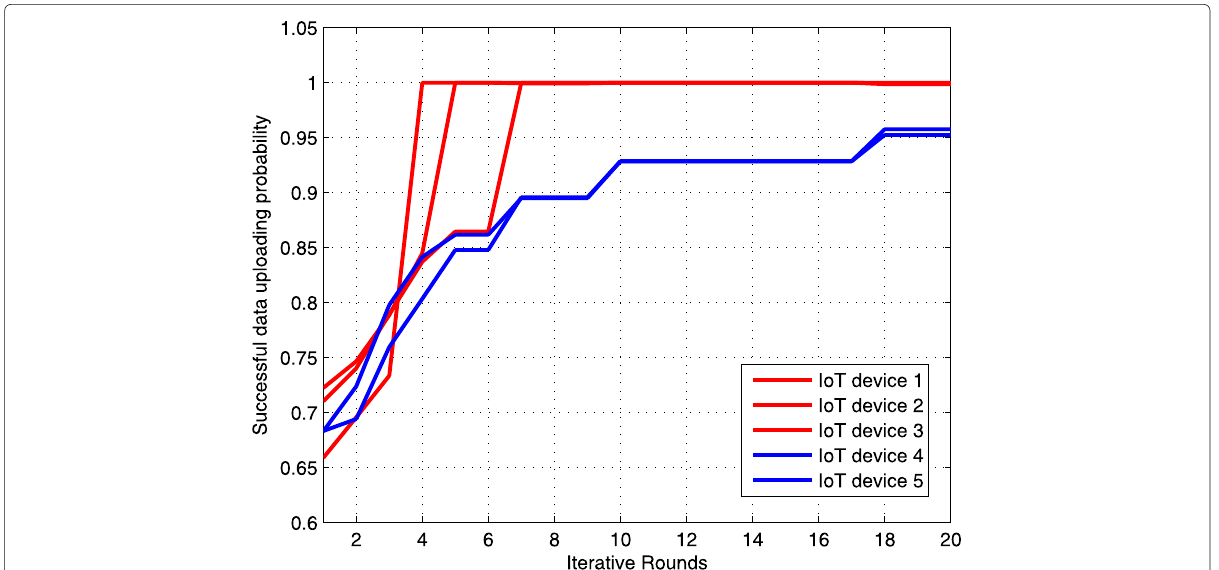
Fig. 8 The successful data uploading probabilities of individual IoT devices. The figure shows the successful data uploading probabilities of